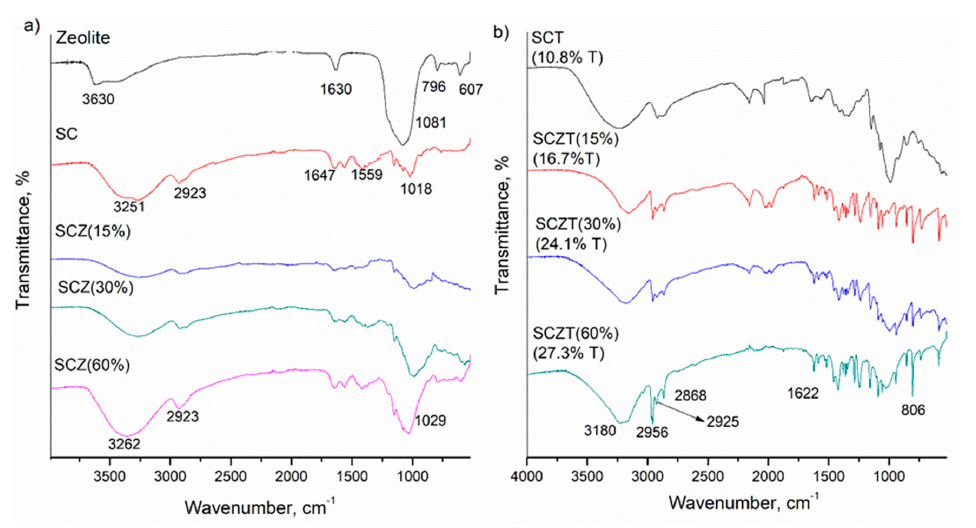
Figure 2. Spectra of the ( a ) control SC and SCZ films and ( b ) thymol impregnated films.